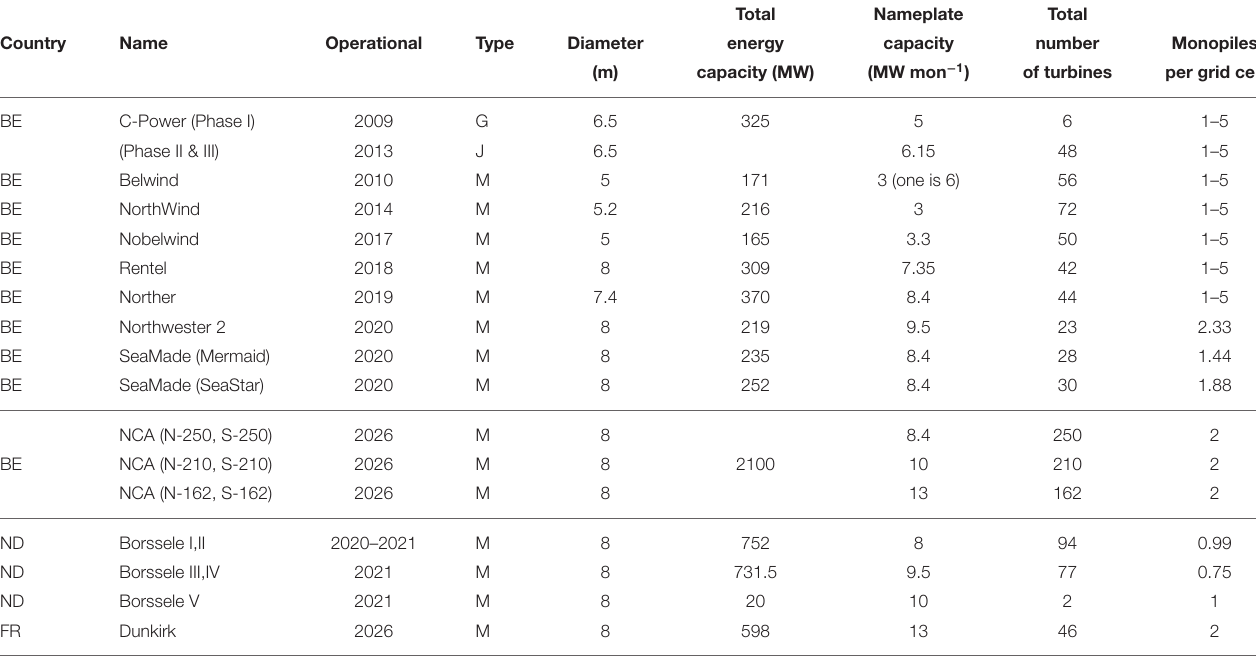
TABLE 2 | Information about existing and planned OWFs (see Figure 1 for the localization of each OWF).